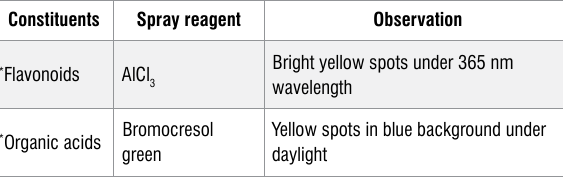
Constituents Reagents Observation